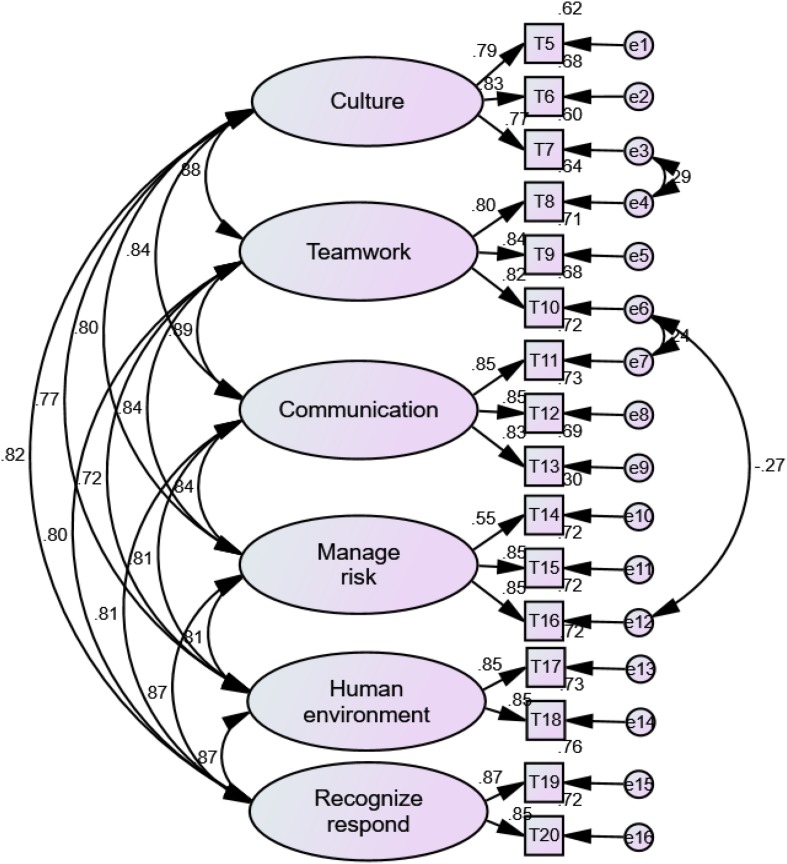
The factor structure of H-PEPSS-CV in classroom version X2/df = 3.19 (p = 0.057), comparative fit index = 0.98, normed fit index = 0.97, Tucker-Lewis index = 0.97, and root-mean-square error of approximation = 0.055.